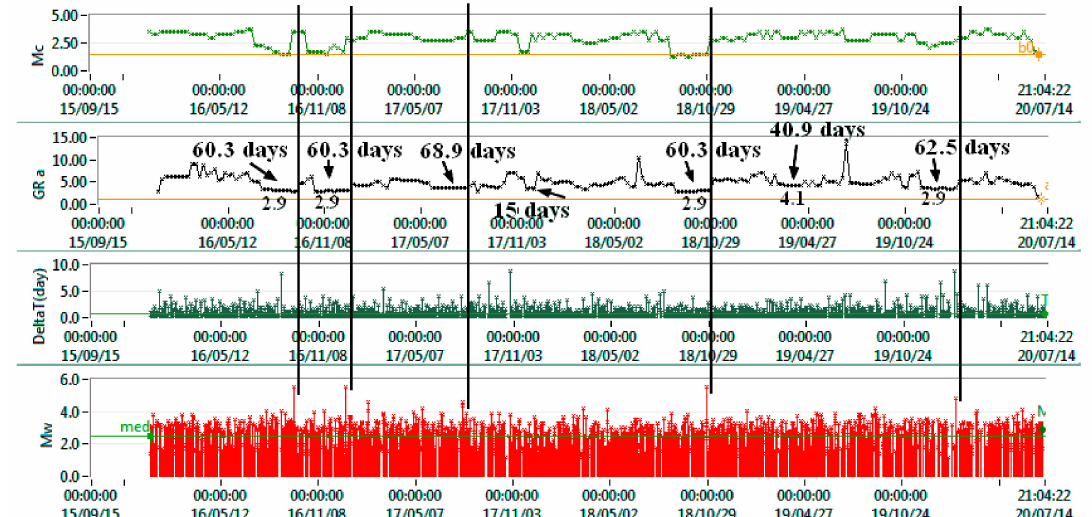
Figure 13. The relationship between Vrancea seismicity and Gutenberg Richter parameters a-b, and the magnitude of completeness Mc.